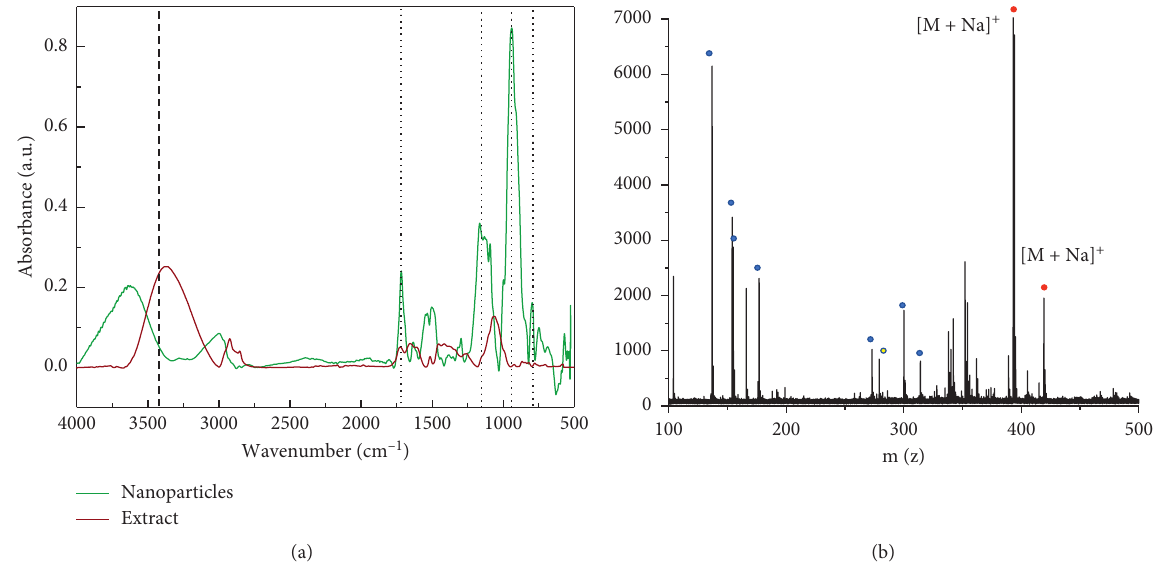
Figure 1: (a) FTIR spectra of the TEC extract and TEC-NP aqueous suspension. (b) MALDI-TOF spectrum in the range of 100 to 500Da of the TEC-NP dried suspension.